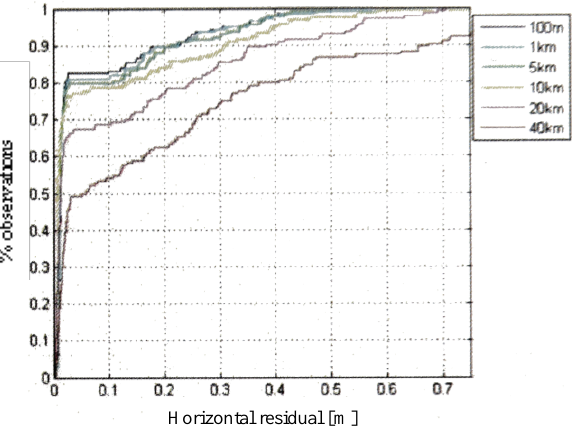
Figure 7. Horizontal residual vs % – u-blox 5T – 10